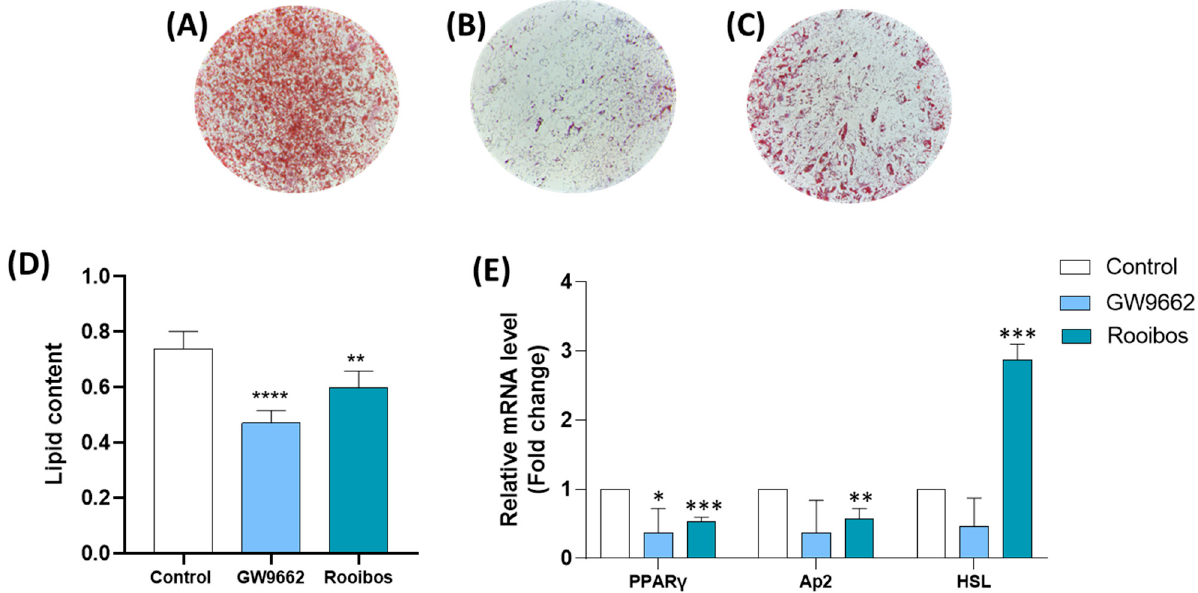
Figure 3. Reduction in intracellular triglyceride content and the expression of adipocyte-related genes in differentiated human adipocytes as a result of Rooibos extract; ( A ) differentiated human adipocyte controls cultured without Rooibos extract and GW9662; ( B ) differentiated adipocytes in the presence of GW9662; ( C ) differentiated adipocytes in the presence of 50 µ g/mL Rooibos extract; ( D ) quantification of Oil Red O staining intensity measured (at 490 nm) after 8 days of chronic exposure to 50 µg/mL of Rooibos extract or GW9662. Results for the Oil Red O staining shown are from a representative experiment which was repeated two more times in quadruplicate with similar trends; ( E ) differentiating human adipocytes were grown in the presence and absence of 50 µg/mL of Rooibos extract until day 8. Total RNA isolated from untreated cells was used as the control. Data shown are the relative mRNA expression of PPAR γ , Ap2 , and HSL , normalized to β -actin . Significance is indicated as * where p ≤ 0.05, ** where p ≤ 0.01, *** where p ≤ 0.001 and **** where p ≤ 0.0001 and n = 3–6.